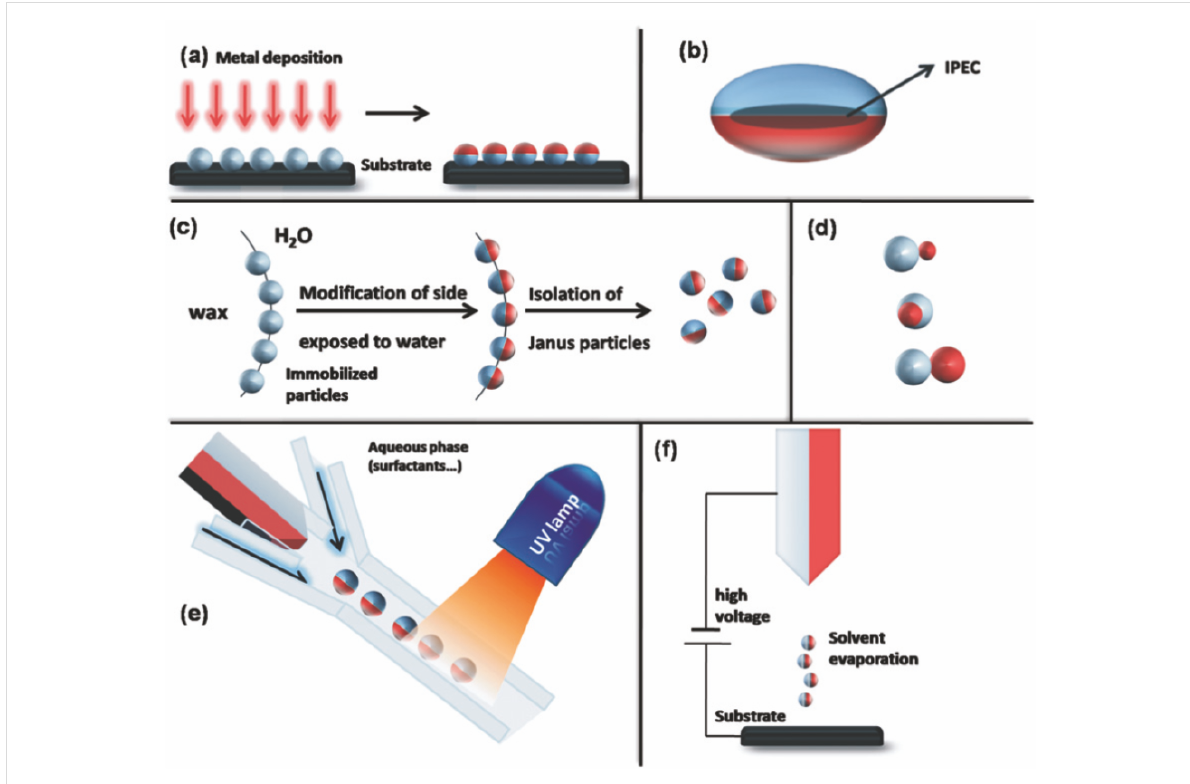
Figure 3: Summary of synthetic routes towards organic Janus particles. (a) Directed functionalization after immobilization, (b) ellipsoidal complex core coacervate micelle with an inter-polyelectrolyte complex core (IPEC), (c) classical Pickering emulsion technique, (d) different topologies of Janus particles: snowman-, acorn-, and dumbbell-like nanoparticles (top to bottom), (e) microfluidic photo-polymerization system, and (f) electrospinning technique with a bi-phasic nozzle. Reproduced with permission from [29]. Copyright 2008 The Royal Society of